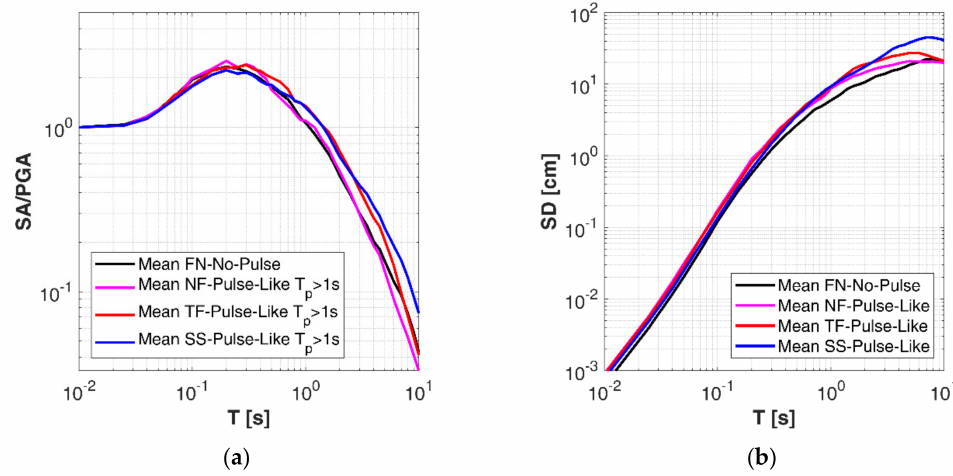
Figure 5. Mean 5% damped acceleration response spectra divided by PGA ( a ) and displacement spectra ( b ) in log-log scale, grouped by styles of faulting (NF—Normal Fault; TF—Thrust Fault; SS—Strike